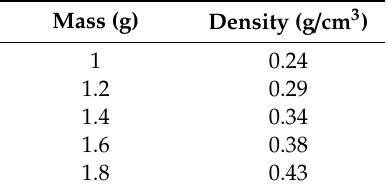
Table 1. Biomass density dependence on mass in the test tubes. Mass (g) Density (g / cm 3